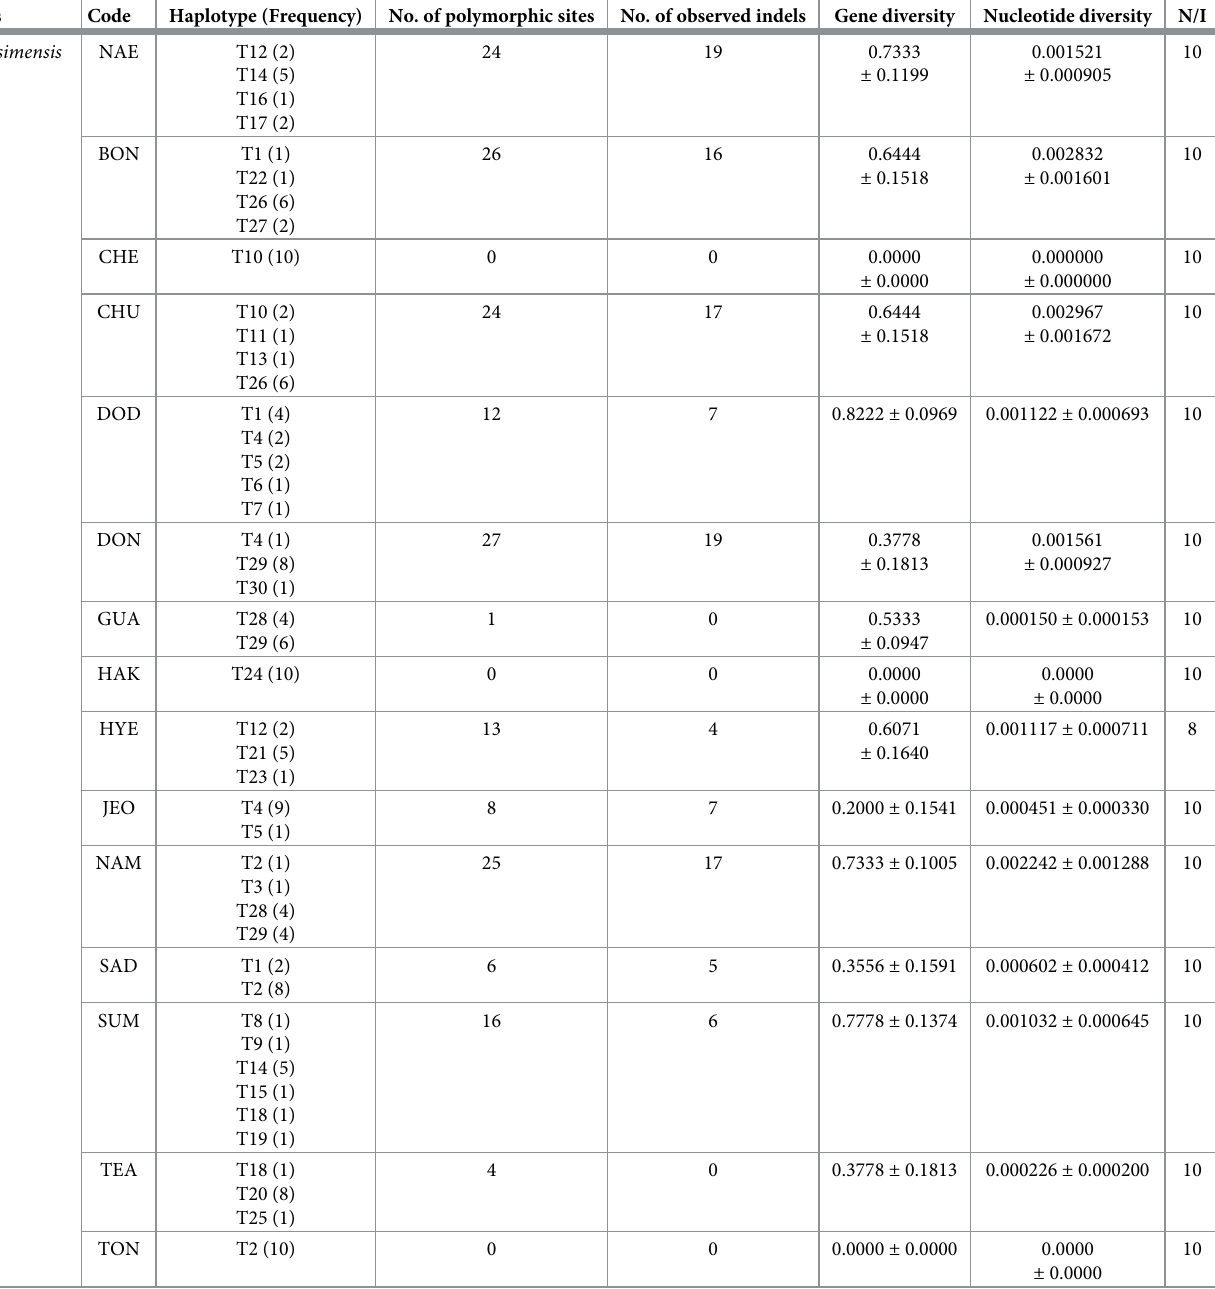
Table 2. Distribution of haplotypes (frequency in parentheses) and gene and nucleotide diversities among populations of insular derived Phedimus takesimensis and two putative continental progenitor species, P . kamtschaticus and P . aizoon .